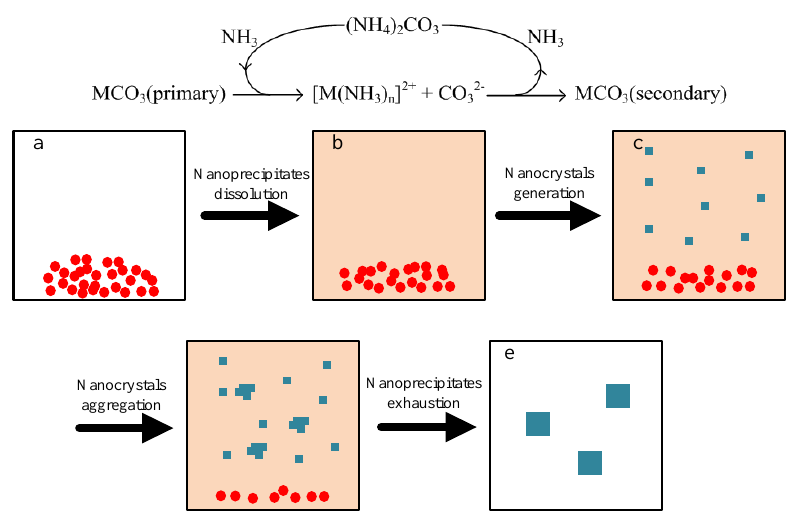
Figure 7. The proposed mechanism for the synthesis of NCM carbonate spheres. The red circles and the blue squares indicate primary nano-precipitates and nanocrystals as the secondary precipitates, respectively.